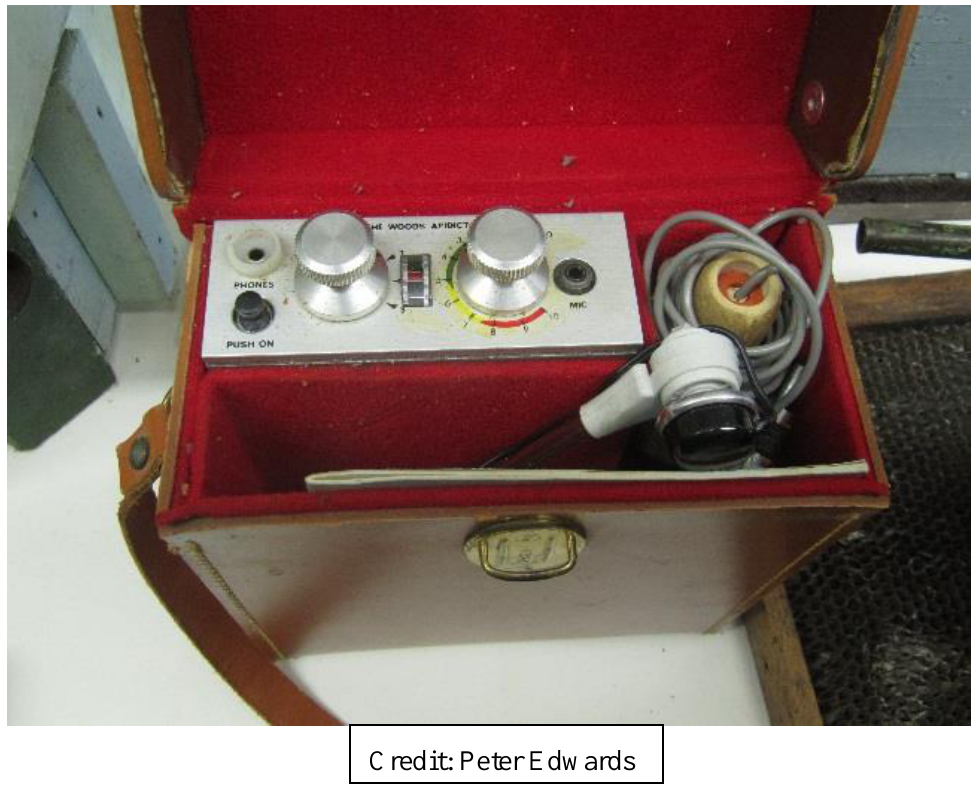
Figure 3. Wood’s Apidictor for honey bee colony swarm